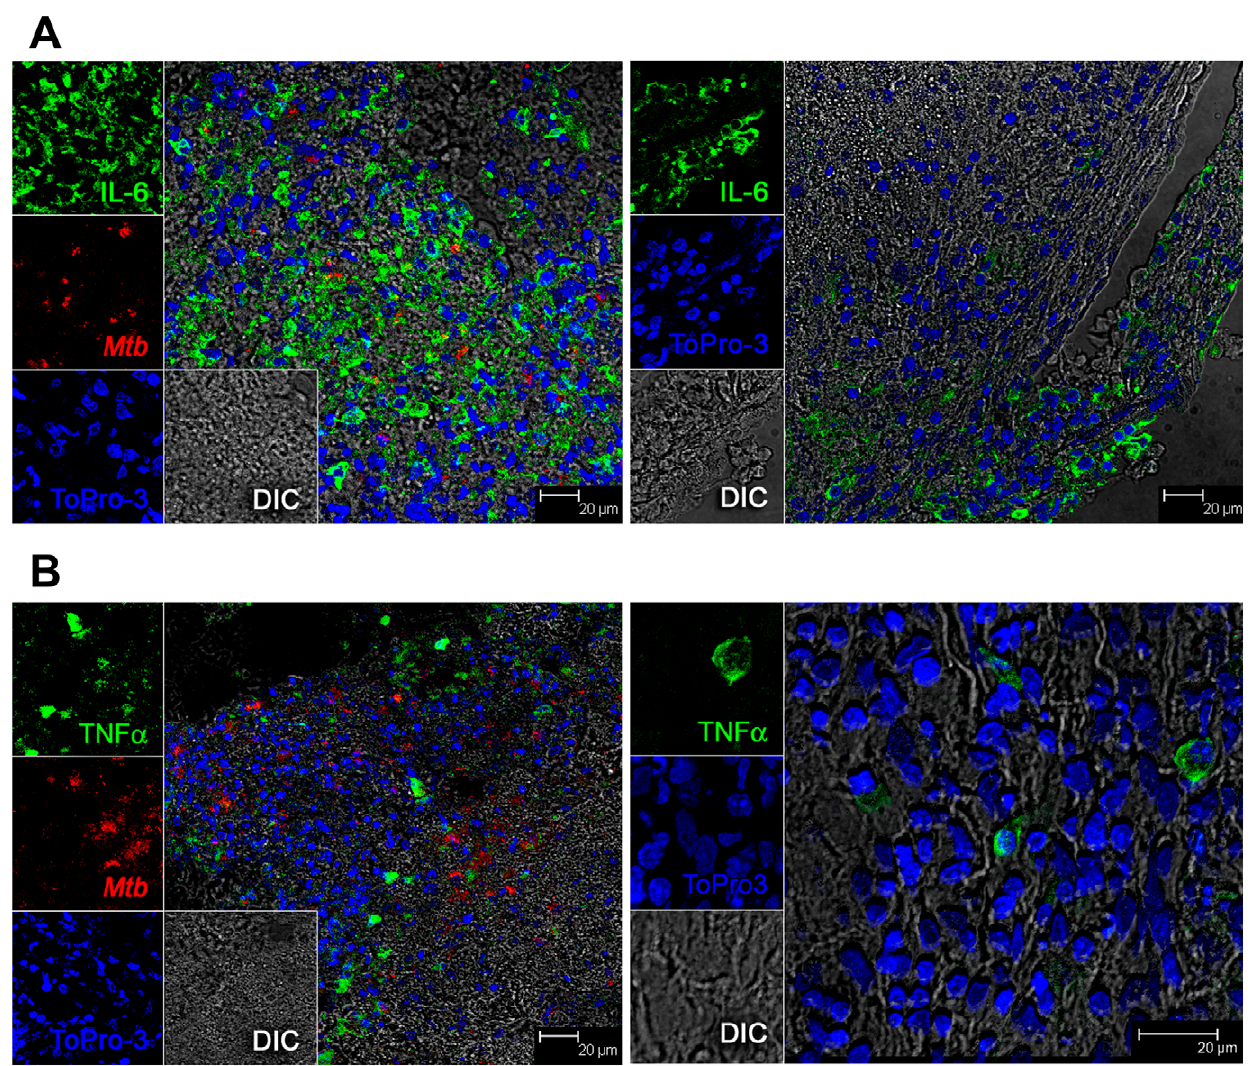
Figure 6. Confirmation of transcriptome results by confocal microscopy. Confocal microscopy shows differential expression of pro- inflammatory cytokines IL6 (A) and TNF a (B) in week 4 (left panels) and week 13 (right panels) lesions. Immunofluorescence was performed on tissues obtained from two animals – one ‘‘early’’ and one ‘‘late’’ animal.